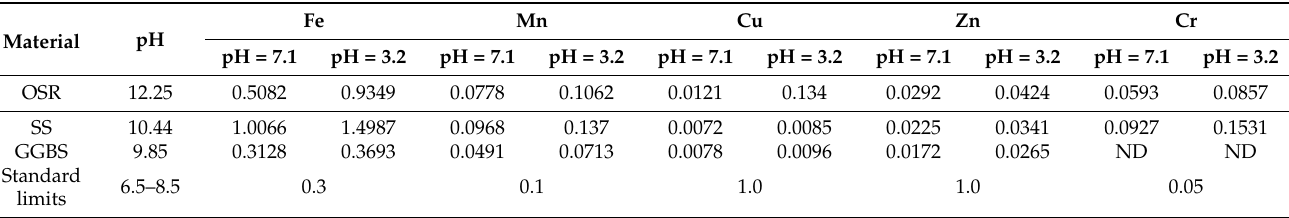
Table 8. Leaching results obtained for OSR, SS and GGBS.